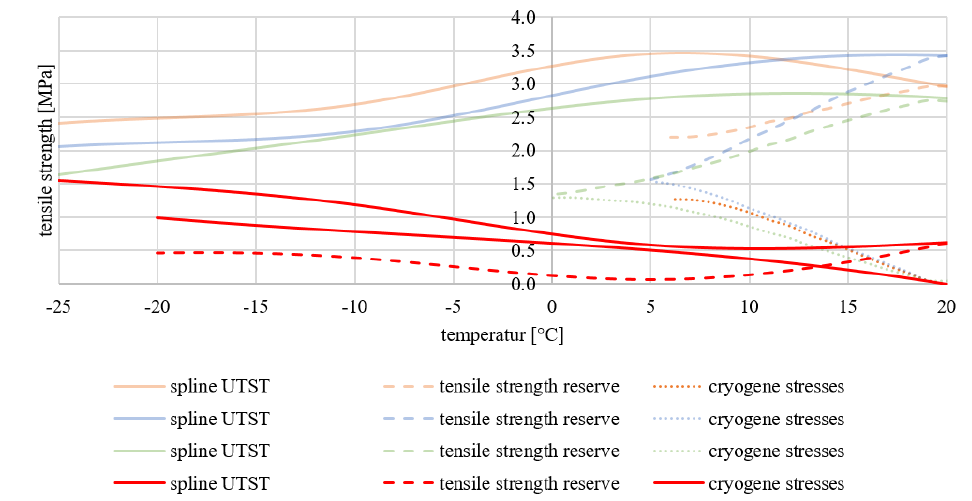
Figure 11. Results of the UTST and TSRST compared to [3]: RAP0 (orange), RAP25 (blue) and RAP50 (green), Ref. [3]